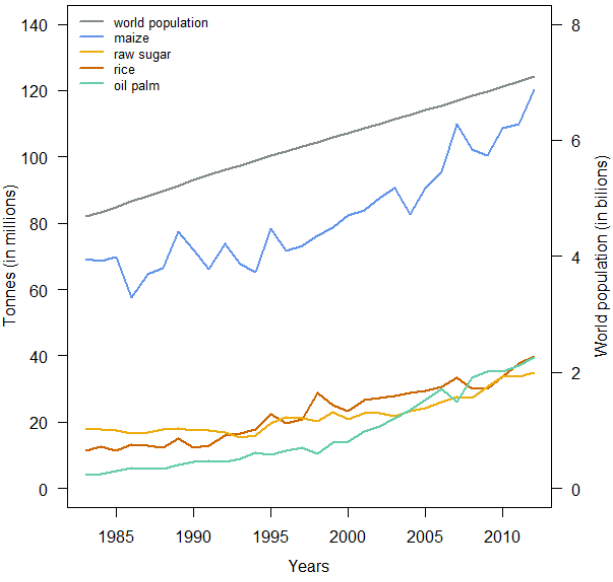
Fig. 1 . Global trade in key agricultural commodities (FAO 2016) versus increases in the world population from 1980 to 2015 (UN